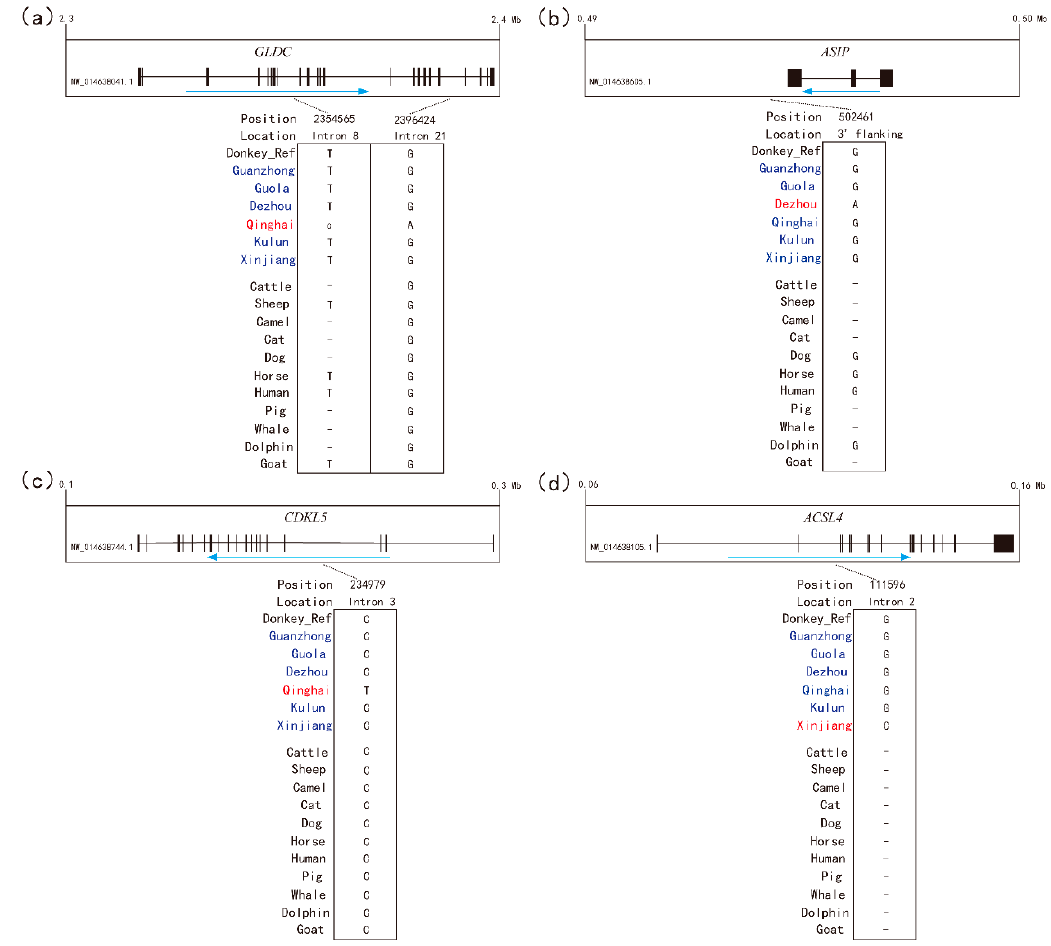
Figure 4. The conservation analyses identified candidate functional mutations that are specific to donkey breeds. Breed-specific SNVs within or close to the key selected genes. ( a ) GLDC , ( b ) ASIP , ( c ) CDKL5 , and ( d ) ACSL4 were screened, and the SNVs localized to evolutionary conserved sites were retained. The locations and positions of the candidate SNVs are indicated.